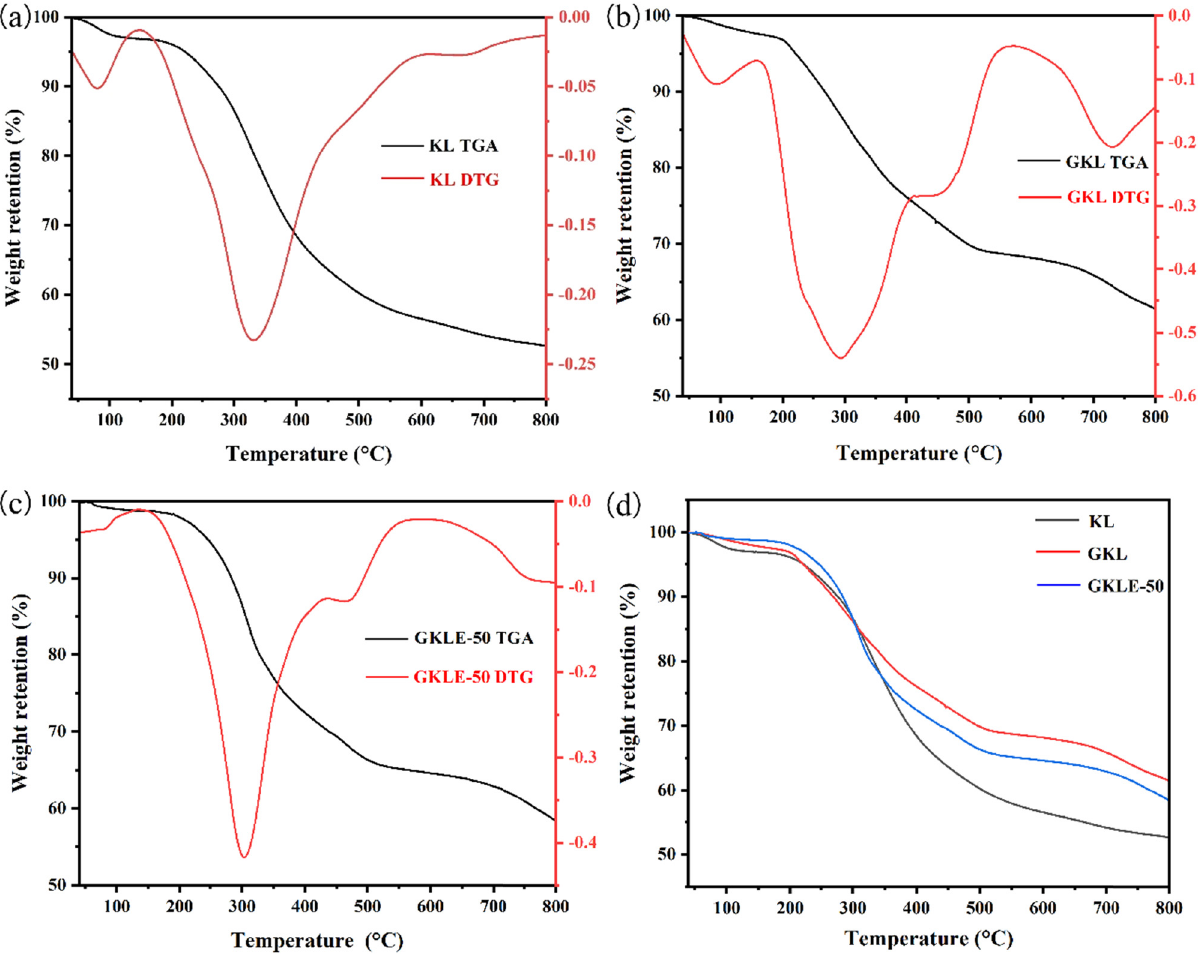
Figure 4: ( a ) TGA and DTG of KL; ( b ) TGA and DTG of GKL; ( c ) TGA and DTG of GKLE - 50; ( d ) TGA of KL, GKL and GKLE -